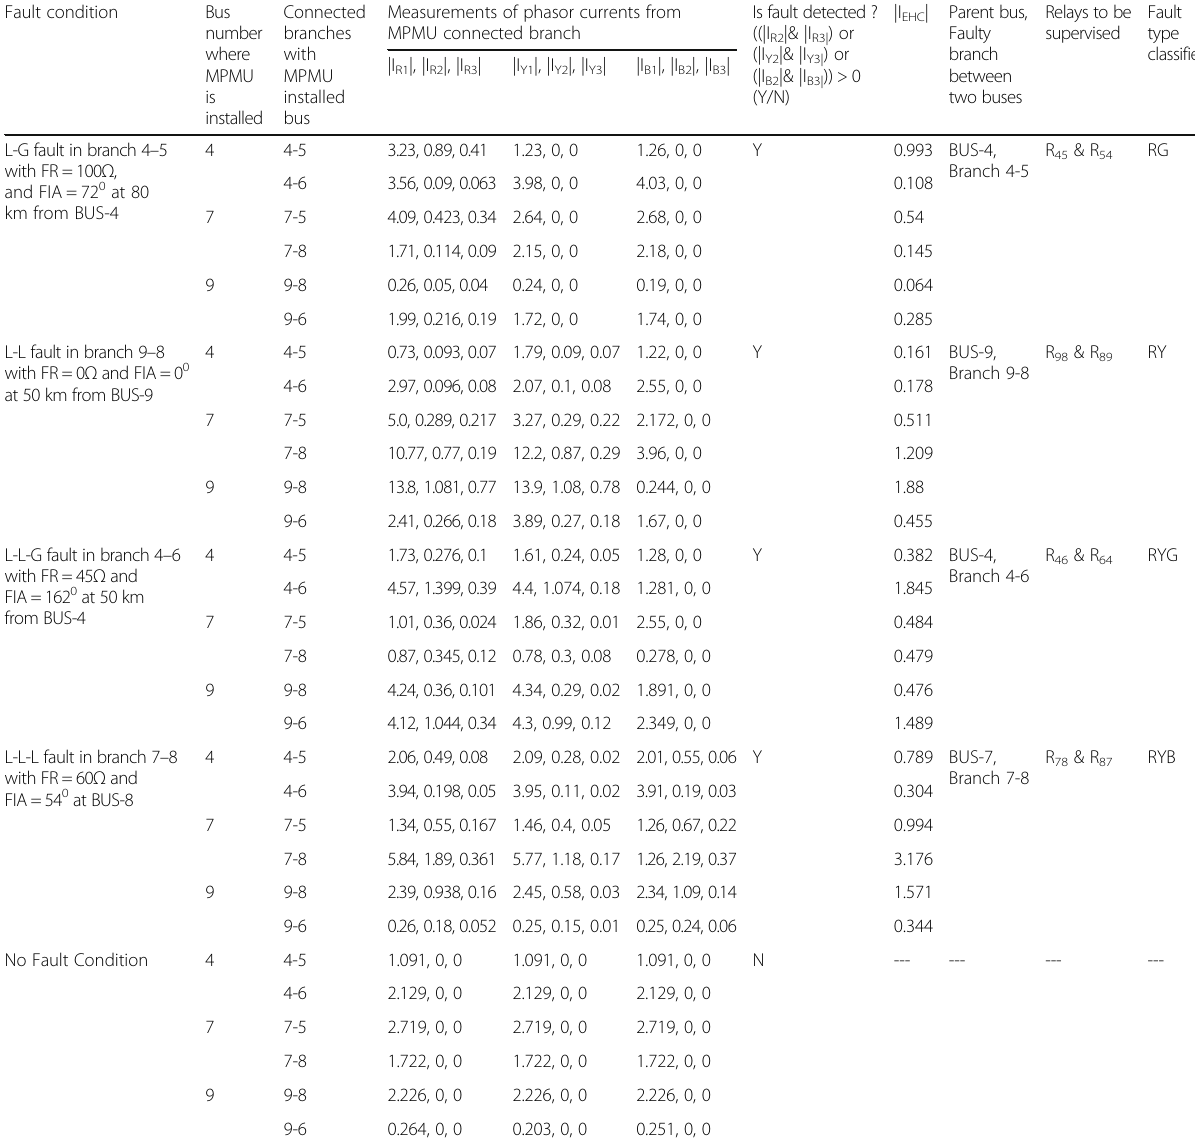
Table 1 Results of case studies, various faults with different fault conditions, conducted on WSCC-9 bus system Fault